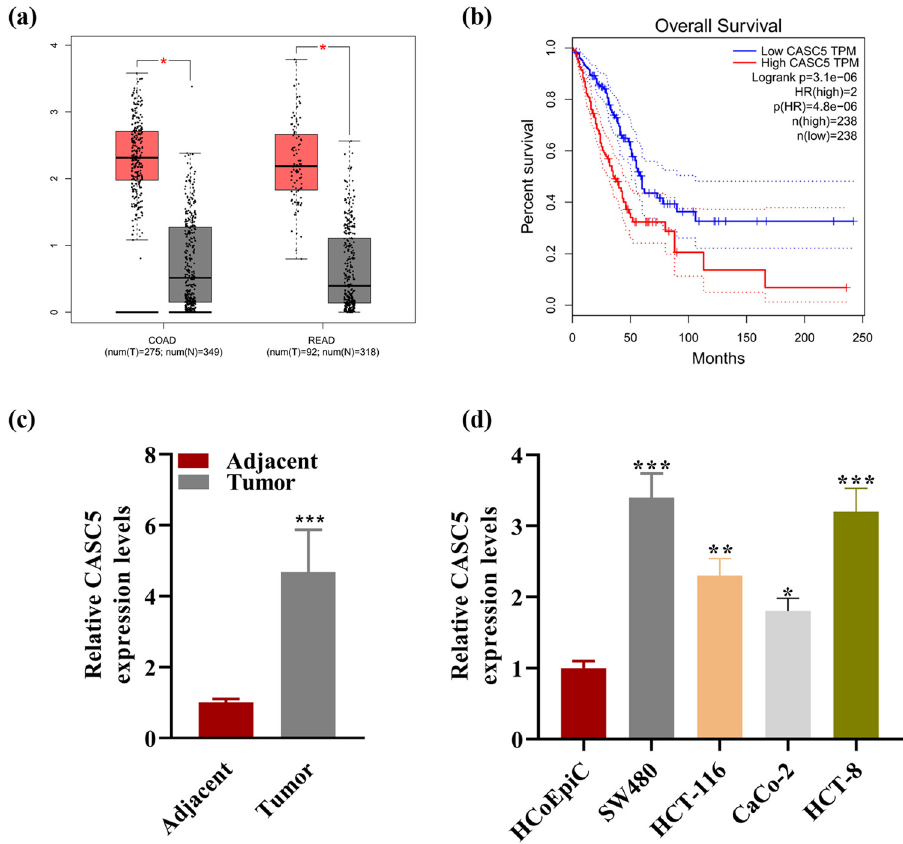
Figure 1: ( a ) The distribution of CASC5 in COAD ( 275 tumor samples and 349 normal samples ) and rectum adenocarcinoma ( READ, 92 tumor samples and 318 normal samples ) . Red column represented tumor samples, and gray column represented normal samples. ( b ) The overall survival curve of patients with low and high CASC5 TPM based on GEPIA database using Log - rank test. ( c ) Relative CASC5 expression in adjacent and tumor. ( d ) Relative CASC5 expression in HCoEpiC and four other CRC cell lines. * P < 0.05, ** P < 0.01, *** P <